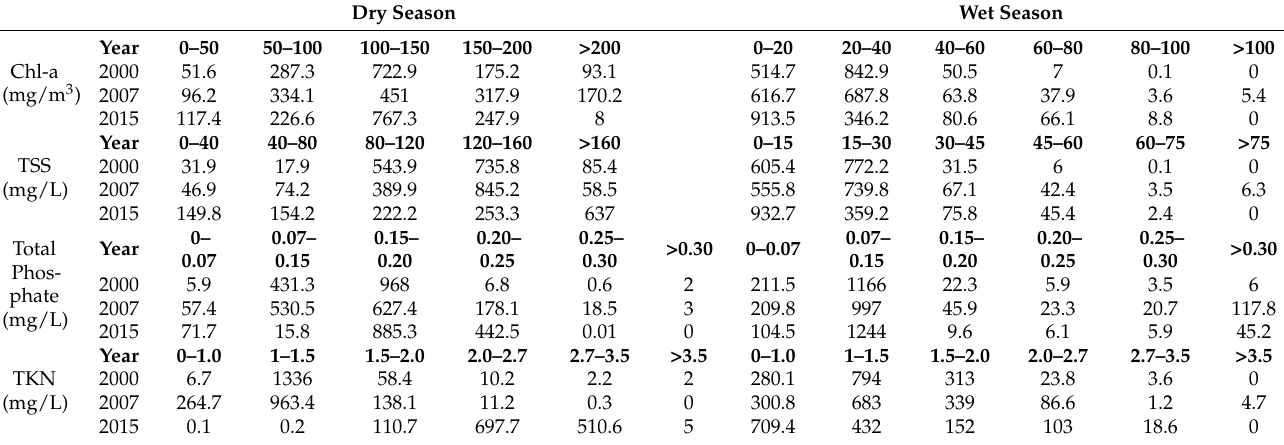
Table 8. The area-based condition of water quality parameters in Lake Okeechobee in dry and wet seasons, and in three years of 2000, 2007, and 2015 (km 2 ) in the ranges of selected